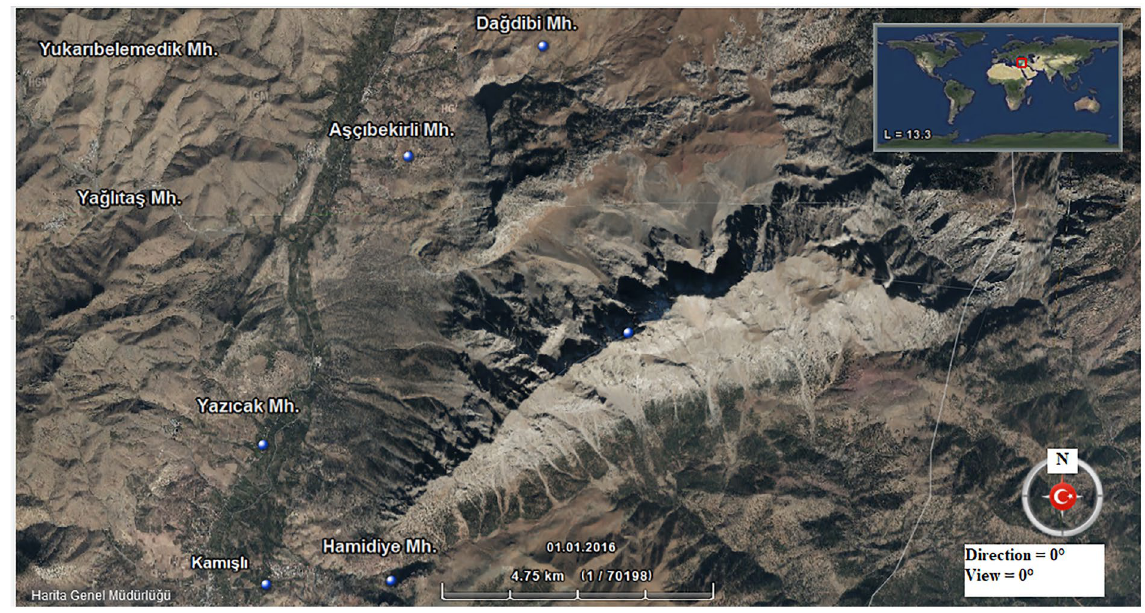
Fig. 3 Satellite image of meteorological stations in the study area (Drawn from HGM Sphere Atlas Editor-